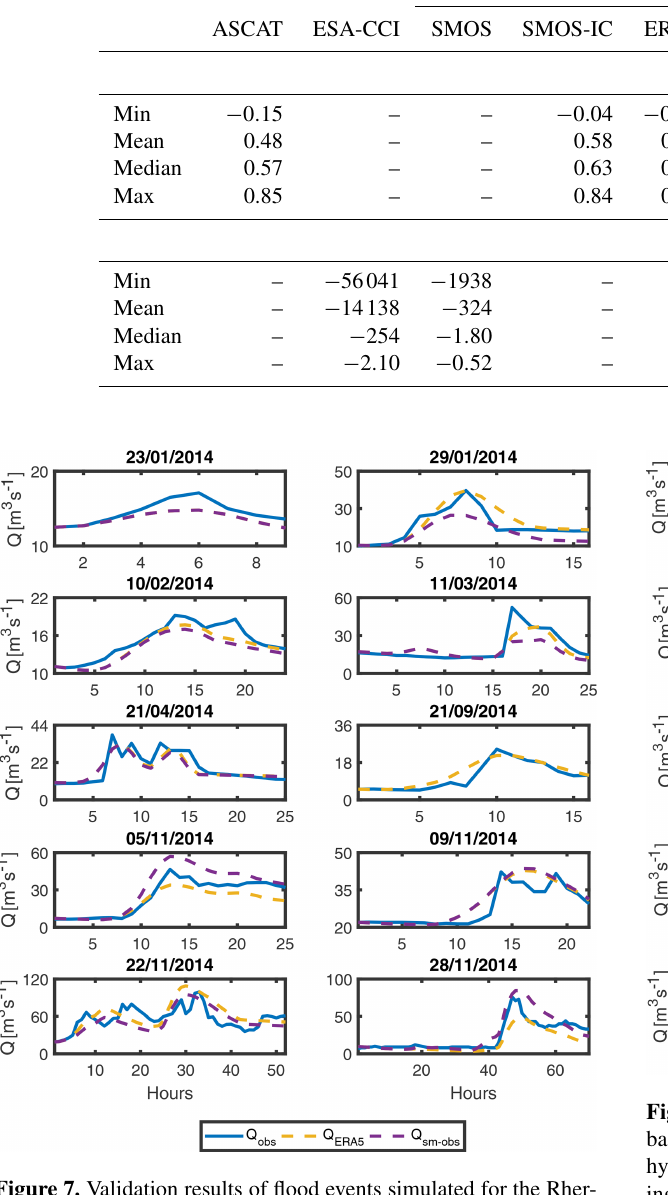
Figure 7. Validation results of flood events simulated for the Rher- aya using different soil moisture products with an hourly time step: the observed hydrographs ( Q obs ) are compared to the simu- lated hydrographs using ERA5 ( Q ERA5 ) or observed soil moisture ( Q sm − obs ) to estimate the antecedent soil moisture conditions. The selected flood events are described in Table 2.